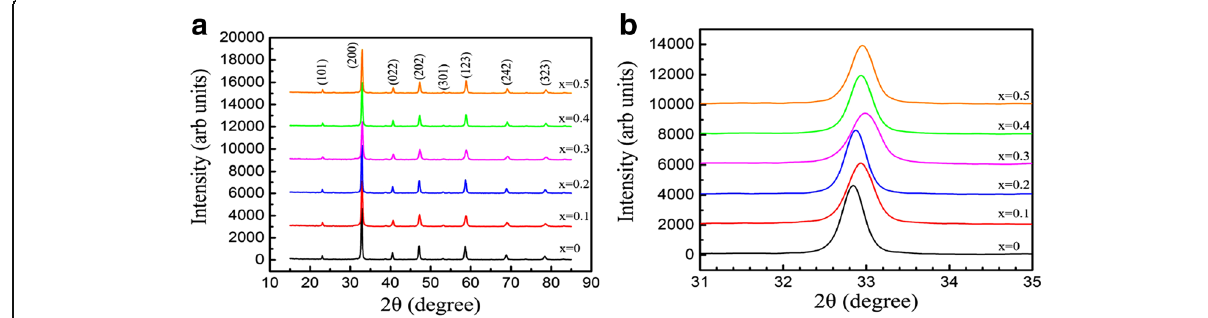
Fig. 2 a X-ray diffraction patterns of the (La 1 − x Pr x ) 0.67 Ca 0.33 MnO 3 ( x = 0.0 – 0.5) nanoparticles post-annealed at 800 °C with different Pr-doping concentrations. b Local (2 θ = 31 – 35 o ) XRD patterns around the strongest diffraction peak (200)